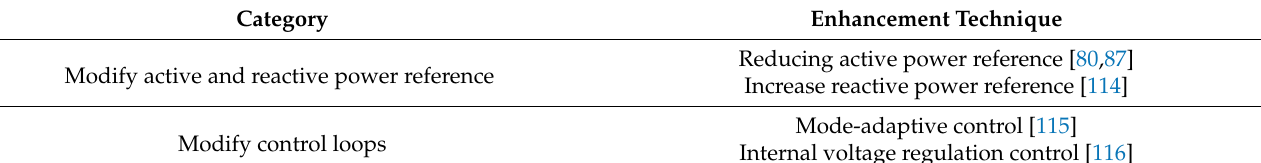
Table 2. Transient stability enhancement techniques for GFM